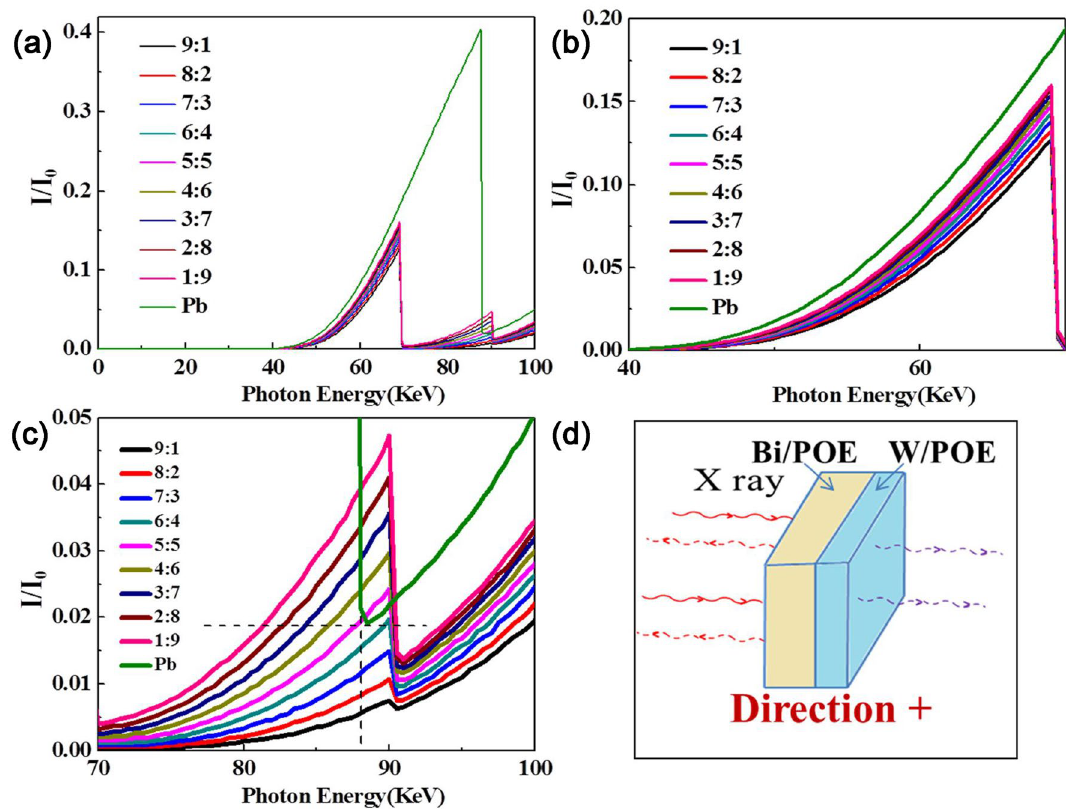
Figure 7. ( a ) X-ray transmission simulation results of the (Bi/POE)/(W/POE) layered composites in the range of 0–100 keV; ( b ) simulation results in the range of 40–70 keV; ( c ) simulation results in the range of 70–100 keV; ( d ) Structural sketch of the (Bi/POE)/(W/POE) layered composites, and incident direction was the “Direction +